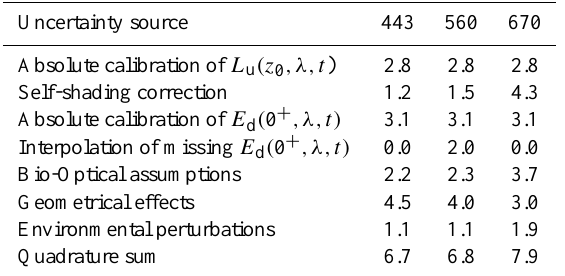
Table 4. Uncertainty budget (in percent) for R rs determined from TACCS-S